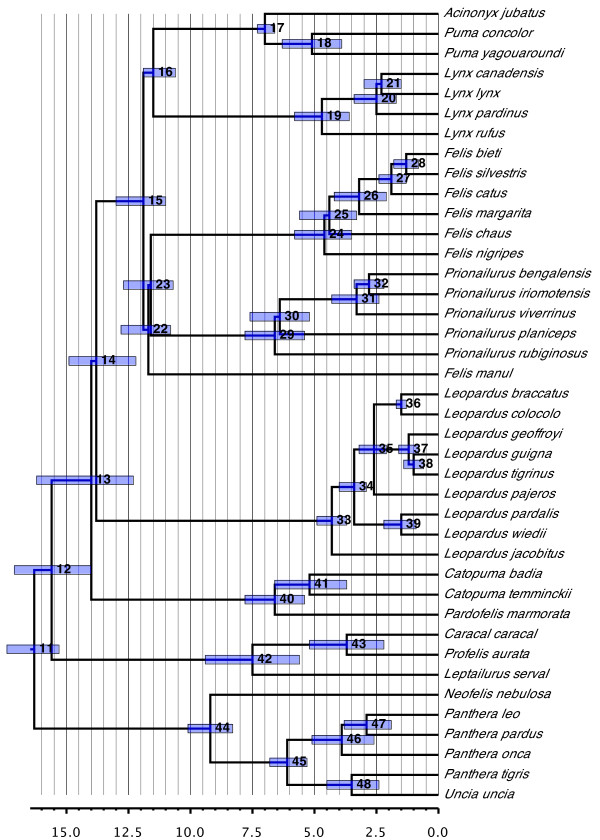
Phylogenetic relationships and divergence times estimates within Felidae. Nodes are individually numbered, with node bars indicating 95% confidence intervals on the divergence time estimates (in Ma before present).